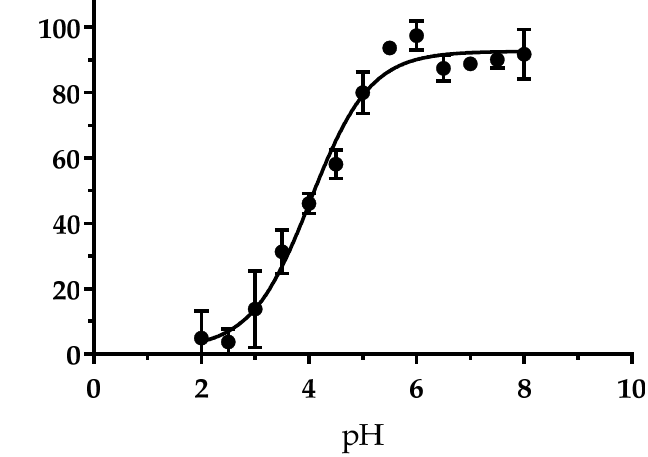
Figure 1. pKa determination of the single cysteine of At GRXS15. Pre-reduced recombinant At GRXS15 (10 µM) was incubated for 15 min with 200 µM 5-iodoacetamido-fluorescein (5-IAF) in buffers ranging from pH 2.0 to 8.0. Fluorescence emission values were then transformed into % thiolate and the values plotted against pH. Data are represented as mean ± SD of three independent experiments.